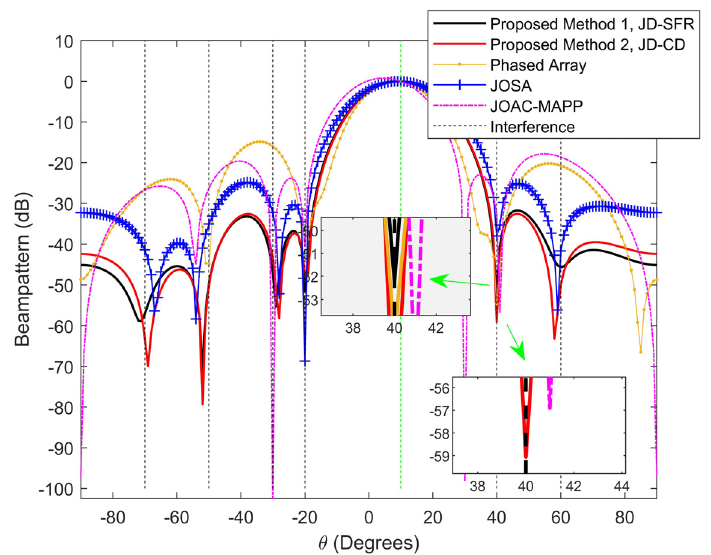
Figure 4. Compare the beampattern of the proposed method and other methods from the angle of interference.